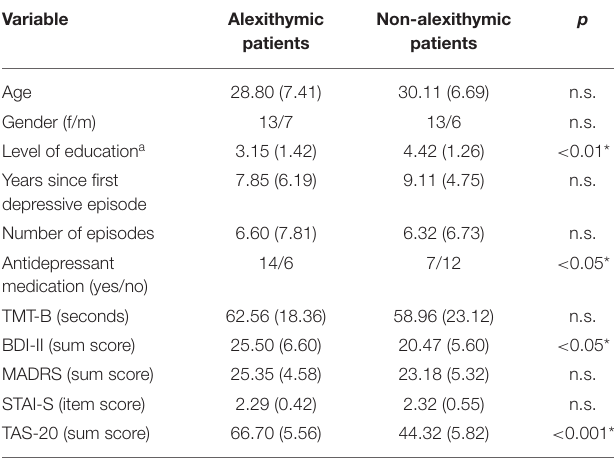
TABLE 1 | Demographic, clinical, and questionnaire characteristics of alexithymic and non-alexithymic depressed patients [means and SD (in brackets) or frequency values].